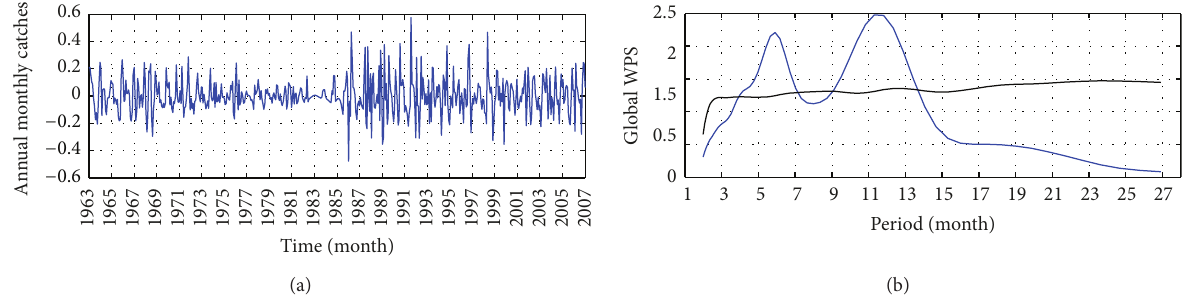
Figure 2: (a) Annual component ( 𝑥 𝑎 ) from 3 -level SWT and (b) GWPS.